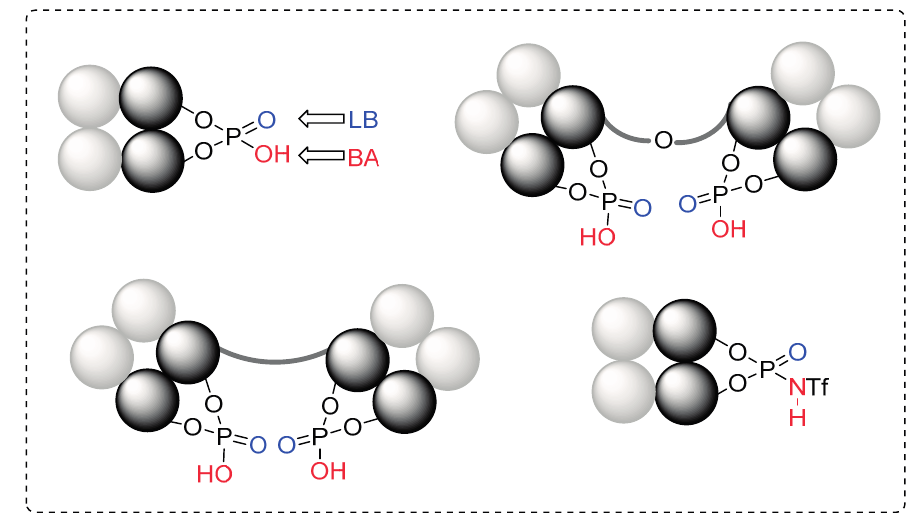
Figure 1. Schematic presentation of bifunctional organocatalysts discussed in this article. LB = Lewis Base; BA = Brønsted